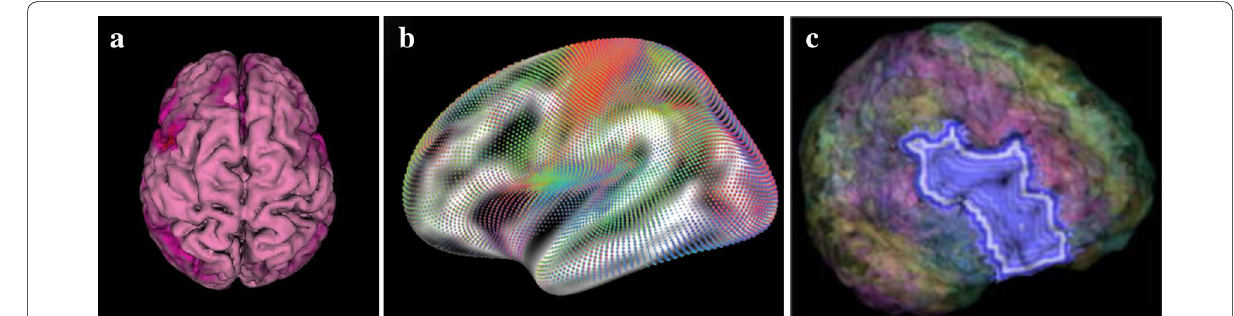
Fig. 8 Examples of anatomy-based visualisations; these minimise the cognitive load required to map fMRI information back to the anatomy. a The connectivity data in a heatmap on the brain surface (created in MindSeer [81]). The software also allows for volume and raw fMRI visualisation in a cutaway fashion. b Glyph visualisation on a slightly inflated brain surface (Böttger et al. [82] via the NeuroBeuro [84]). This can present more information for interpretation without adding much extra human processing because it adds more depth and texture in the glyphs. c An extension to surface heatmaps (from Li et al. [83]) which encodes extra temporal information into the ROI surfaces. This information could be used to help understand underlying data